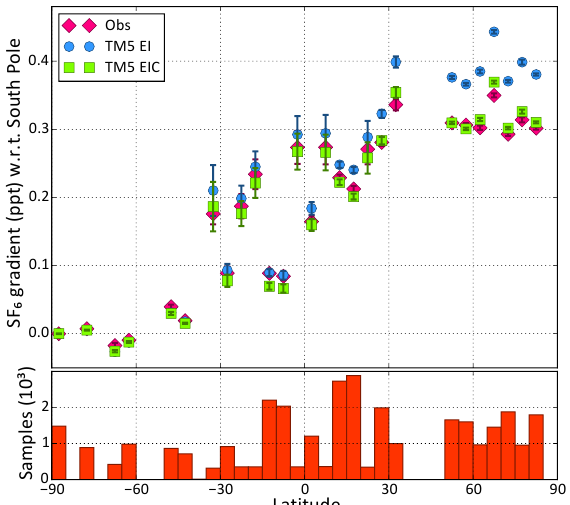
Figure 2. The observed and modeled latitudinal gradients of SF 6 , estimated as the difference between SF 6 concentrations at marine boundary layer sites of the NOAA ESRL GGRN (http://www.esrl. noaa.gov/gmd/ccgg/ggrn.php) and the South Pole. Observations and models span 10 years from 2002 to 2011. For each site, we account for time-dependent changes by calculating a linear trend from observed SF 6 and removing that from all three time series (observed, TM5 EI, TM5 EIC). All observations were binned by latitude in 5 ◦ increments and averaged. The bottom panel shows the number of samples averaged per latitude bin. The error bars denote ± 2 σ intervals, where σ is the standard error of the mean difference with respect to the South Pole. Measured SF 6 mole fractions used here are available in the